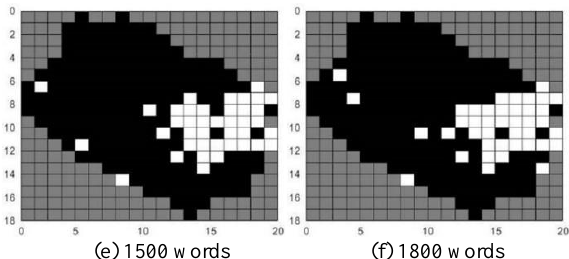
Figure 10. The Benggang recognition labels of our method with six different size of vocabulary